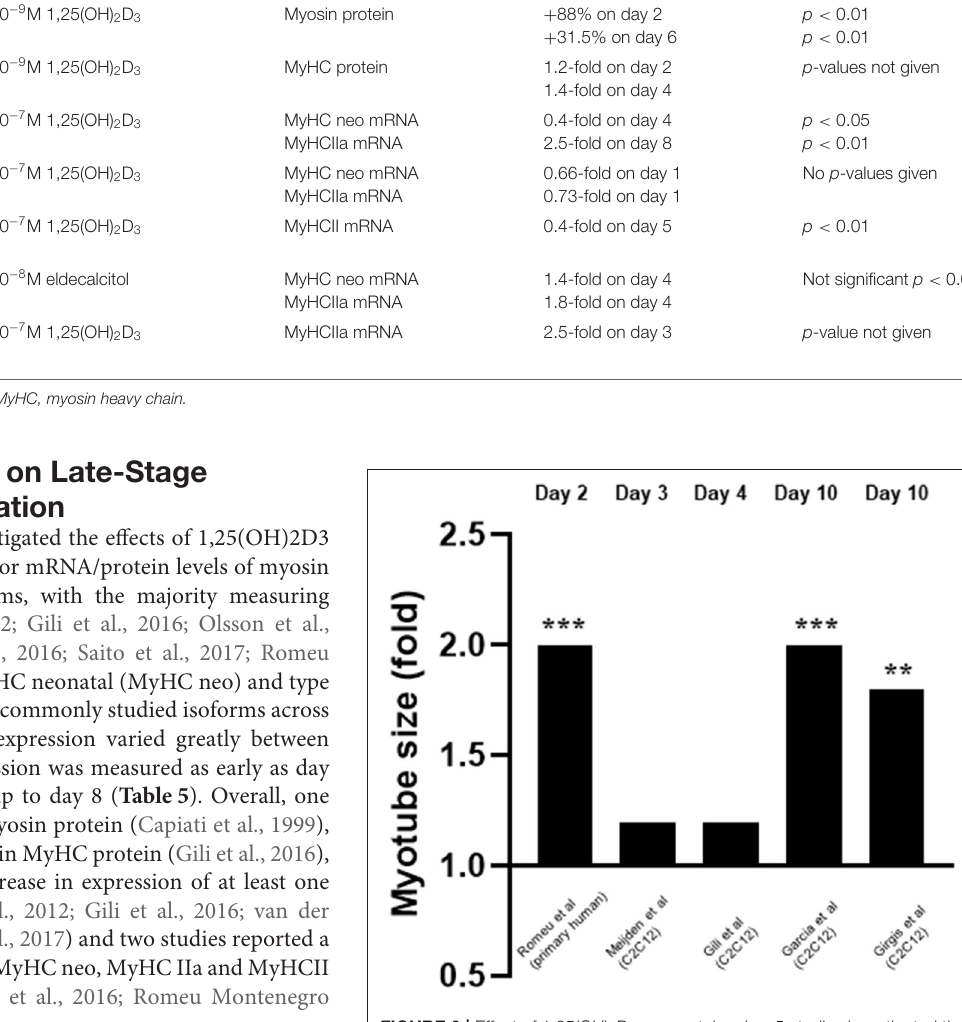
FIGURE 6 | Effect of 1,25(OH) 2 D 3 on myotube size. 5 studies investigated the effect of 1,25(OH) 2 D 3 on myotube size. Myotube size was measured at varying time points which ranged from day 3 to day 10. 1,25(OH) 2 D 3 concentration was 10 − 7 M for all cases apart from Gili et al. (2016) where 10 − 9 M was used. ** p < 0.01, *** p <